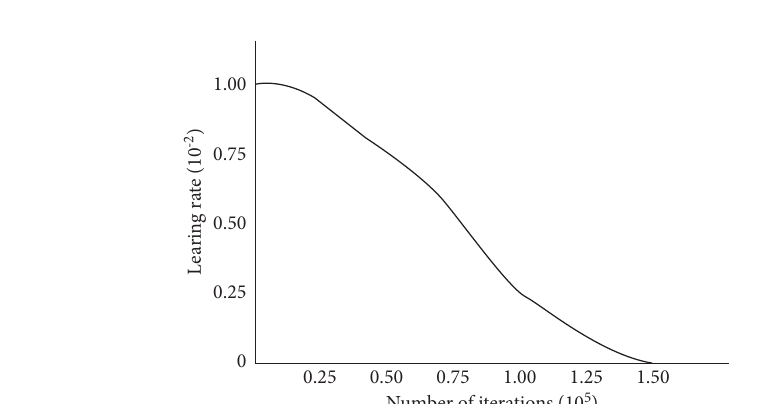
Figure 3: Learning rate decay curve.